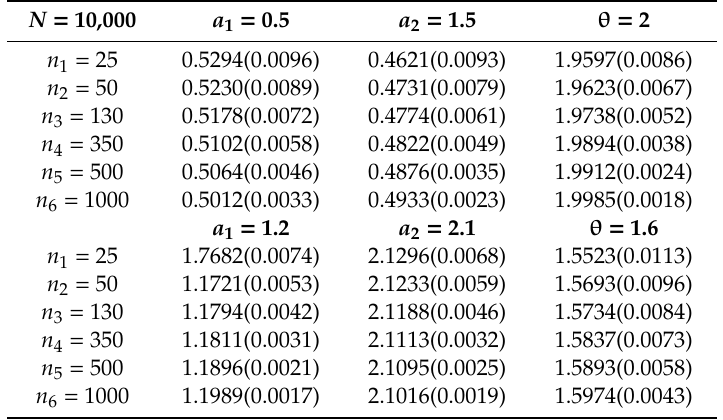
Table 1. The maximum likelihood estimators (MLEs) and their mean squared errors (MSEs).